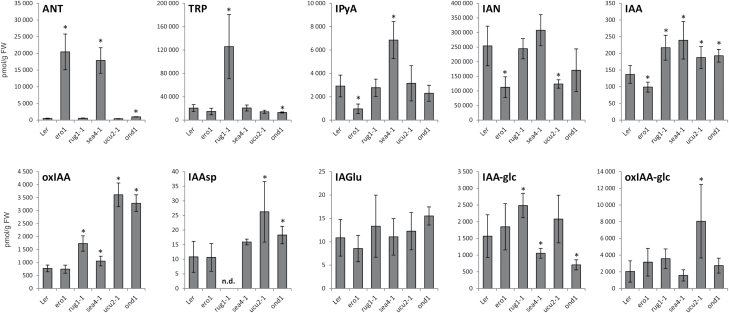
IAA metabolite concentrations in the Ler wild type and the ero1, rug1-1, sea4-1, ucu2-1, and ond1 mutants. Seedlings of wild-type Arabidopsis Ler and mutant lines were collected in five replicates of 10 mg, and the IAA and IAA metabolites were analysed by LC-MS/MS. Error bars represent the SD. Asterisks indicate a statistically significant difference in a two-tailed Student t-test at a significance level of 0.01.